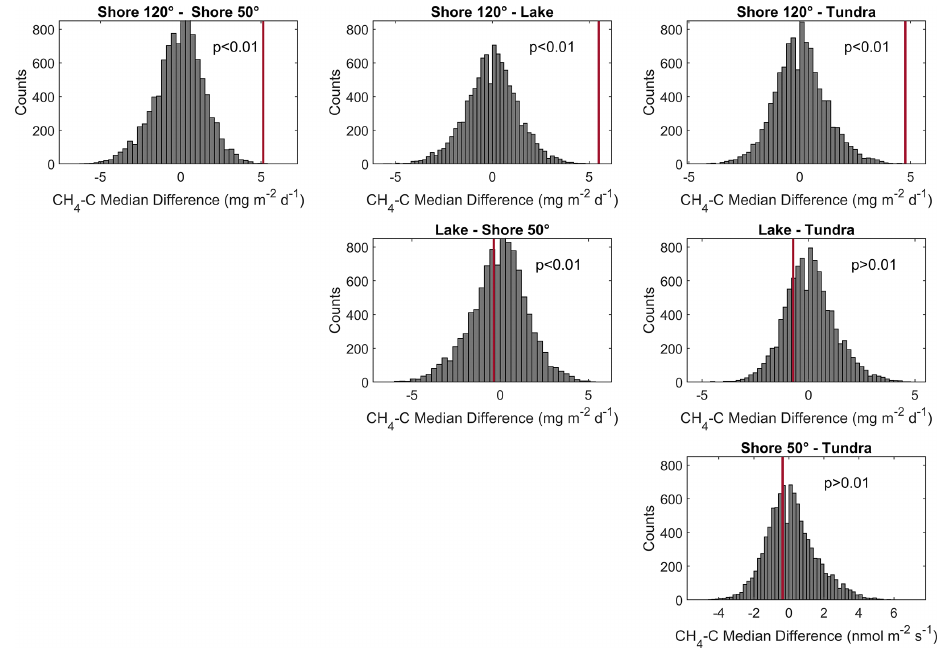
Figure A4. Histogram of permutation tests between the medians of CH 4 emissions from different wind direction classes in Fig. 6. All medians from flux observations during moderate wind-speed conditions. The observed differences in medians between the different wind direction classes are shown in red vertical bars in each plot.